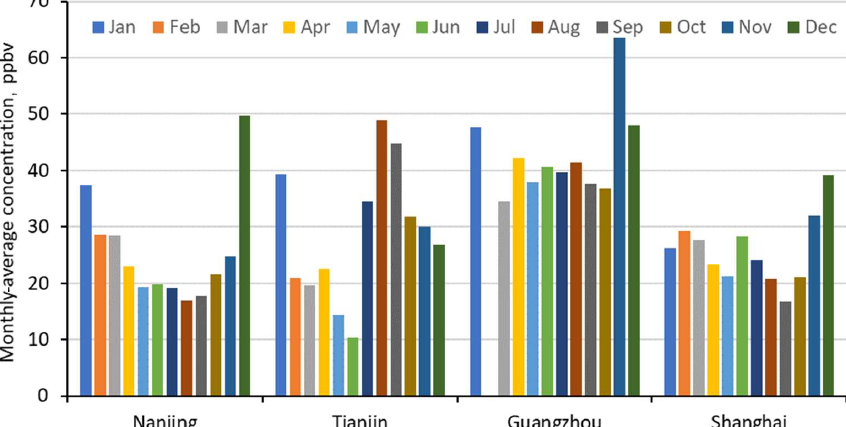
Figure 3. Monthly variability of ambient VOCs at the JAES site and three other Chinese cities: Shanghai (Wang et al., 2013), Guangzhou (Zou et al., 2015) and Tianjin (Liu et al.,